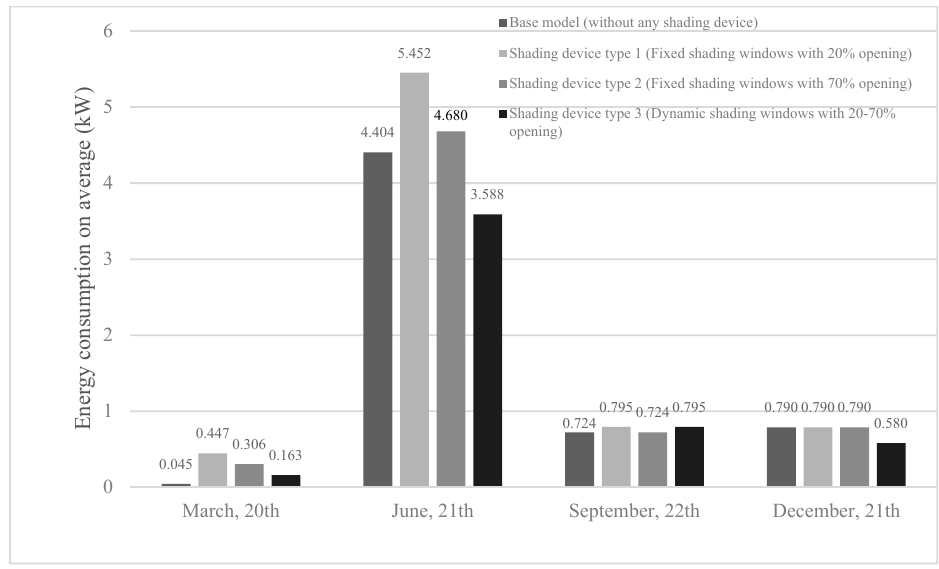
Figure 19. Comparative analysis of energy consumption in proposed options on average. Optimization: